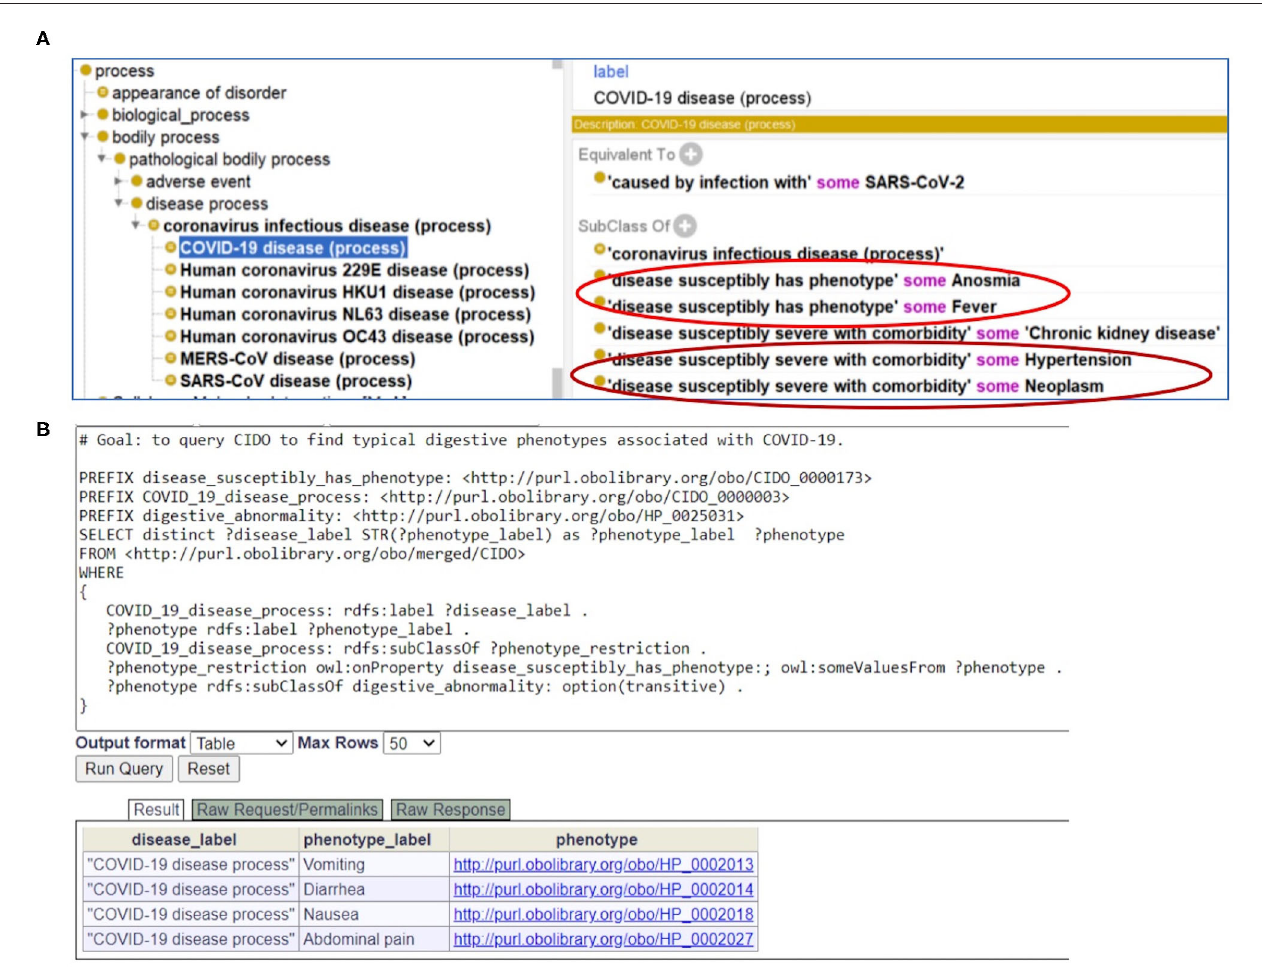
FIGURE 6 | CIDO modeling and analysis of COVID-19 symptoms. (A) Generation and usage of two new relations in CIDO to link COVID-19 to symptoms or comorbidities. (B) SPARQL query of typical digestive phenotypes associated with COVID-19 disease (process). Four phenotypes (i.e., vomiting, diarrhea, nausea, and abdominal pain) were identified. The Ontobee SPARQL website (http://www.ontobee.org/sparql) was used to perform the